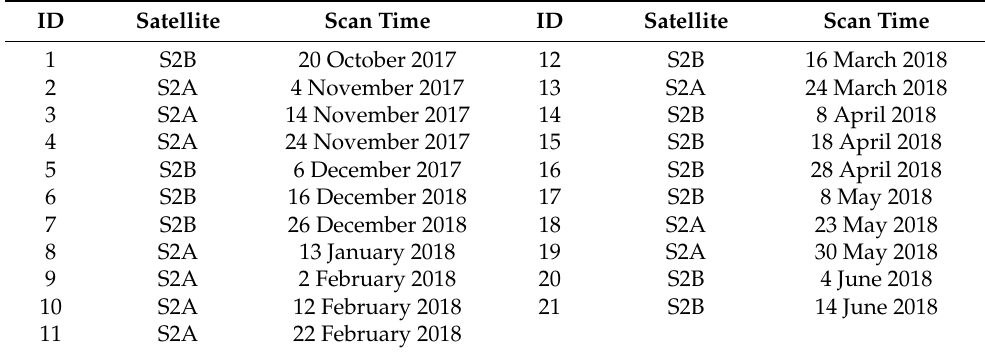
Table 1. List of Sentinel-2 images.